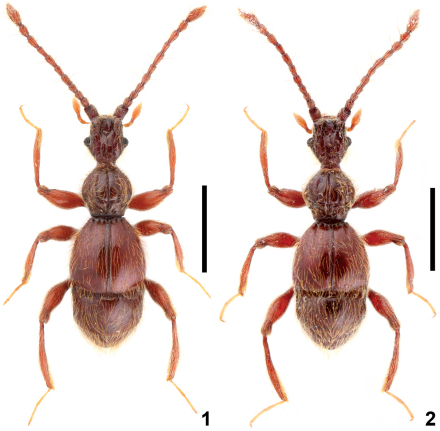
Male habitus of Intestinariusspp. 1 Intestinarius guangdongensis2 Intestinarius  longiceps. Scales: 1.0 mm.